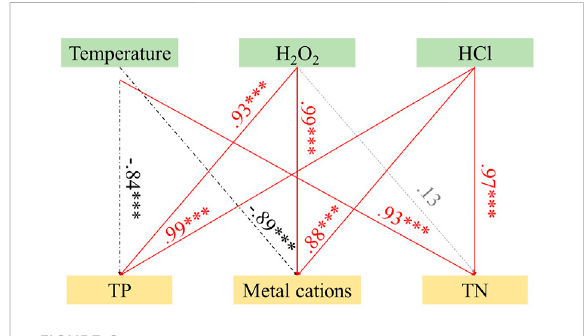
FIGURE 6 Effects of reaction conditions on nutrients and metal ions during thermal